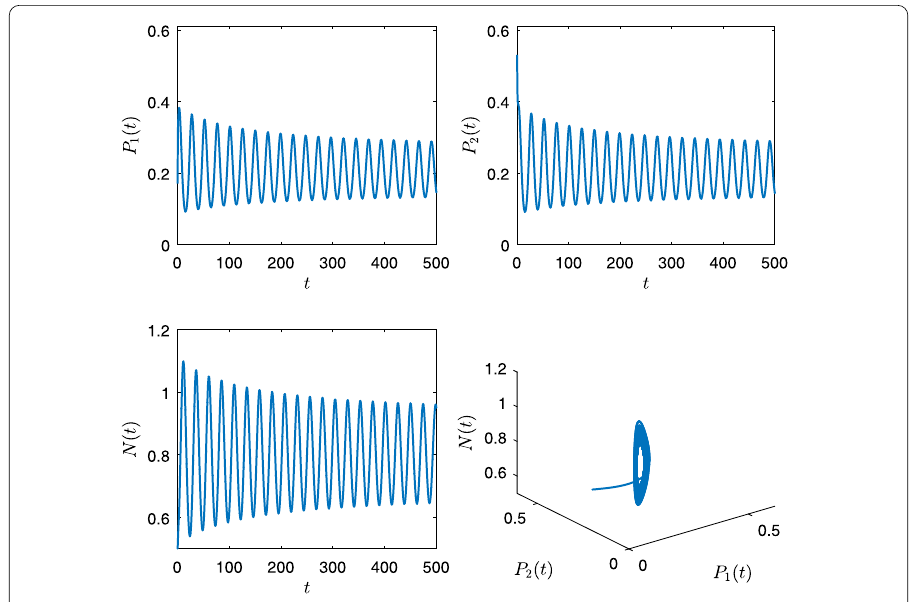
Figure 2 E † of system (34) is unstable by choosing τ = 2.7 > τ 0 = 2.5302